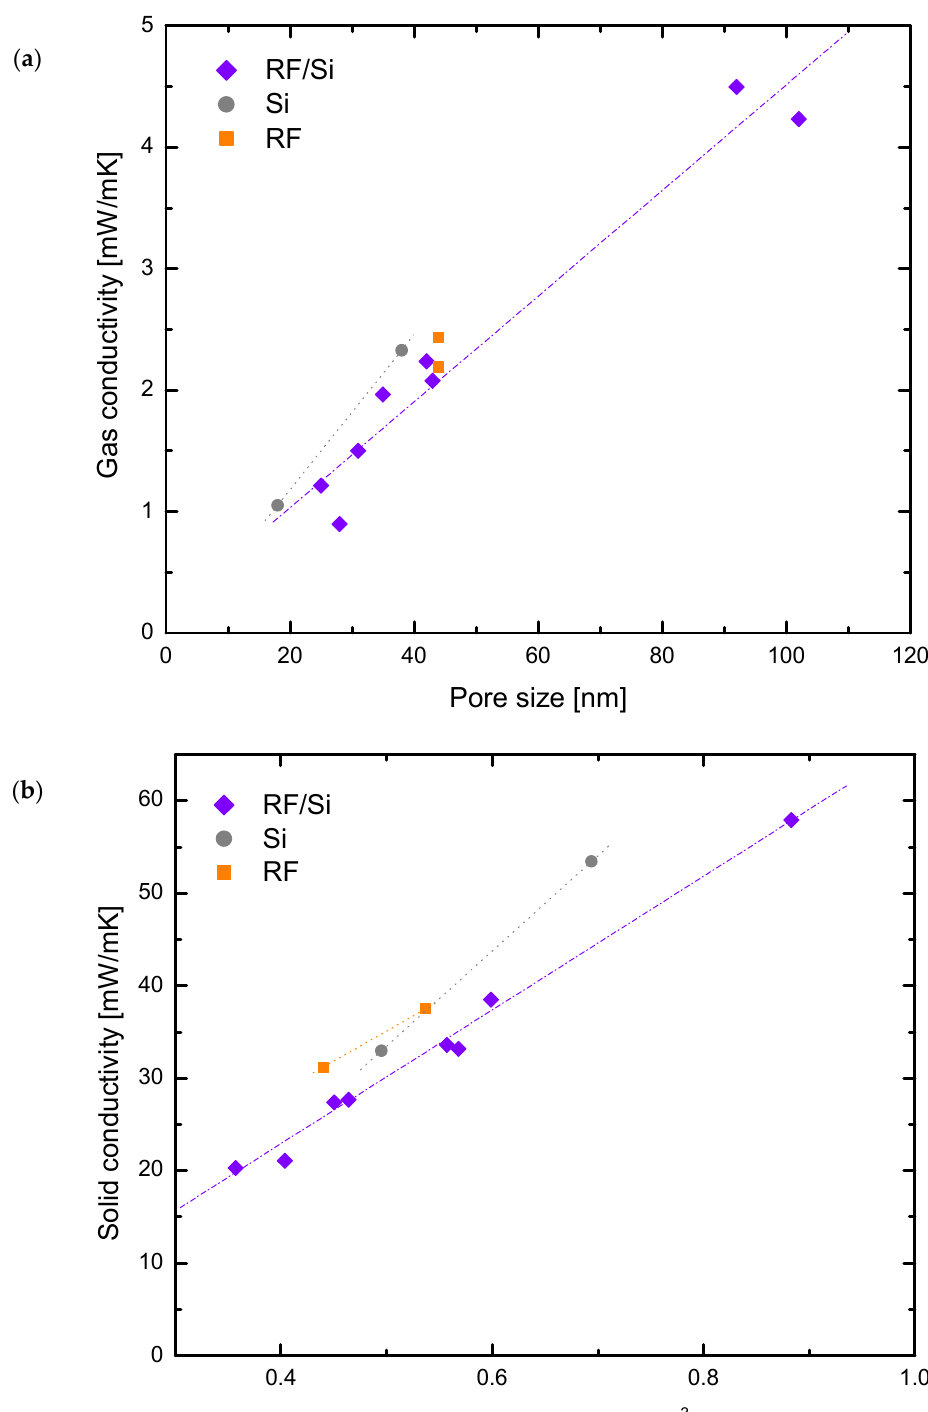
Figure 5. Contribution to the total thermal conductivity of two of the main heat transfer methods: gas conductivity ( a ) and solid conductivity ( b ).